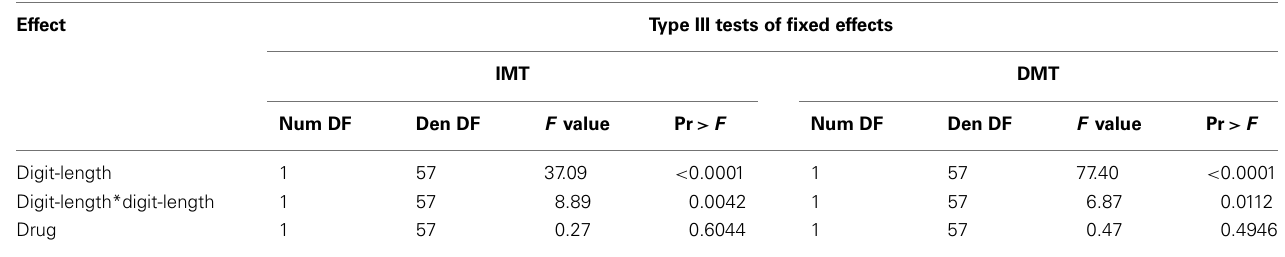
Table 2 | Results of statistical analysis of behavioral data model without interactions.